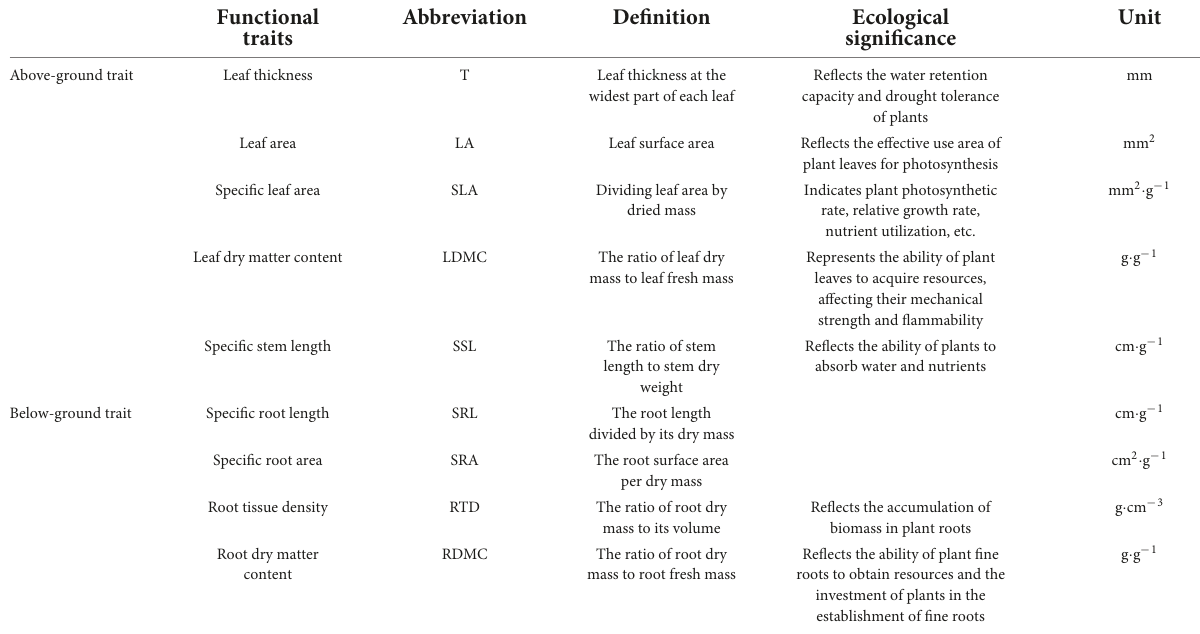
TABLE 1 The definition, abbreviation, and unit for 9 functional traits of Abies georgei var. smithii